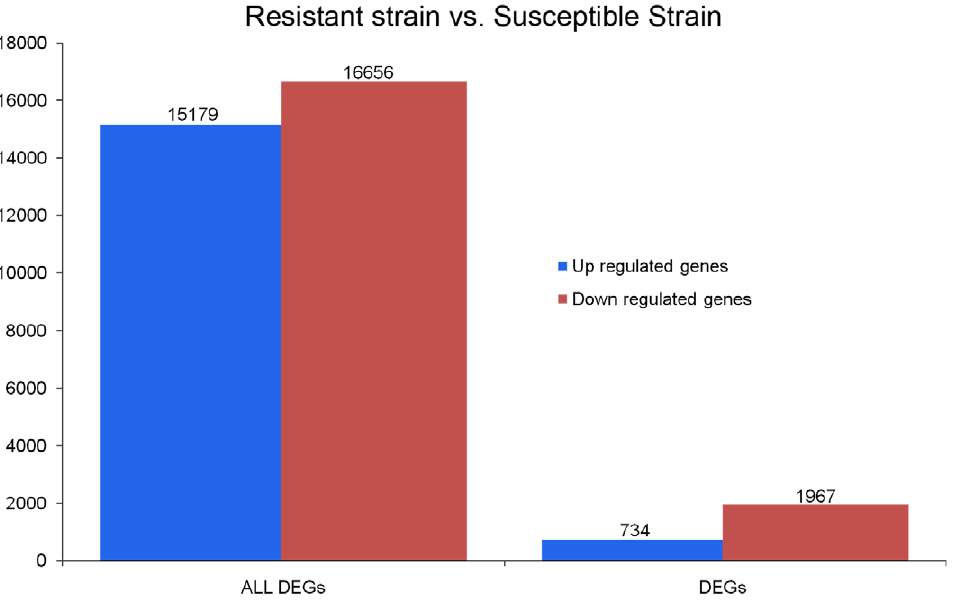
Figure 4. Differences in gene expression profile between the Resistant Strain and Susceptible Strain. ‘ALL DEGs’ indicates those unigenes showing differential expression between the two samples, while ‘DEGs’ indicates those unigenes with FDR # 0.001 and |log 2 Ratio| $ 1. The numbers of genes up-regulated and down-regulated in the Resistant Strain relative to the Susceptible Strain are indicated above the blue or red bars, respectively.